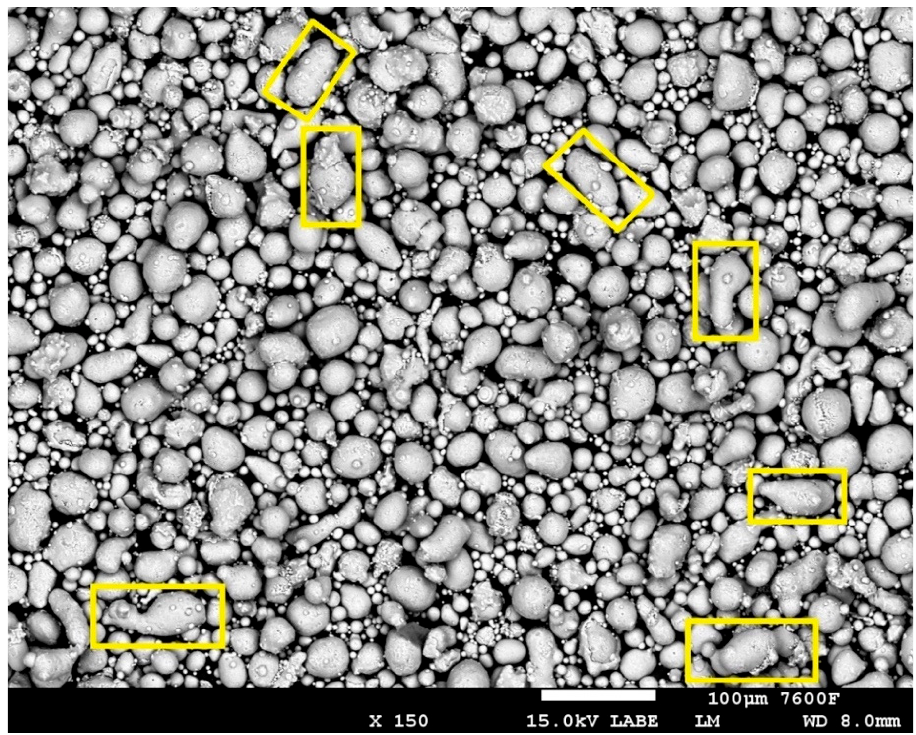
Figure 1. SEM image of used AlSi10Mg powder; particles significantly larger than 45 μ m are high- lighted. Table 3. List of heat treatment modes of L-PBF AlSi10Mg used in the experiment.